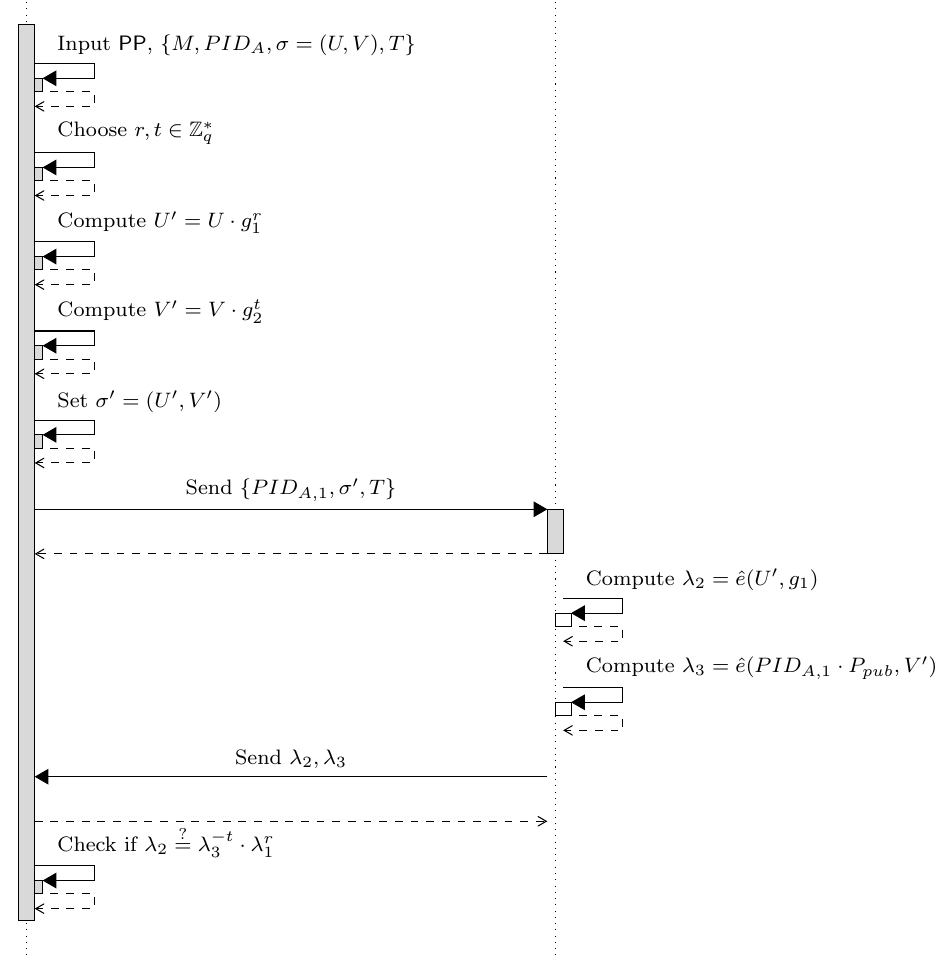
Figure 3. Interaction between Bob and CSP in server-aided